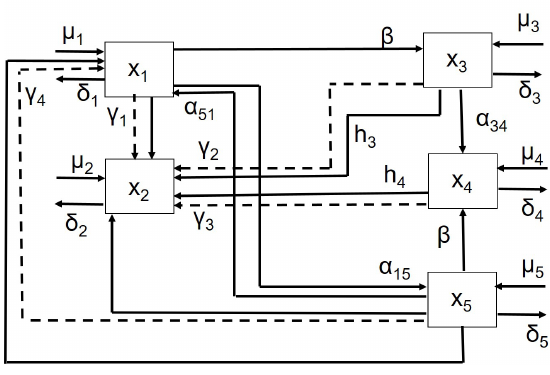
Figure 1. Block diagram of the considered